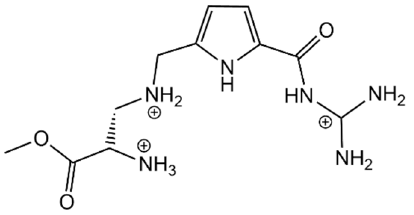
Figure 18. Structure of the guanidinium pyrrole receptor, GP3cat [59]. Table 1. Binding constants ( K a ) for the formation of host-guest complexes between amino acids and synthetic supramolecular receptors.